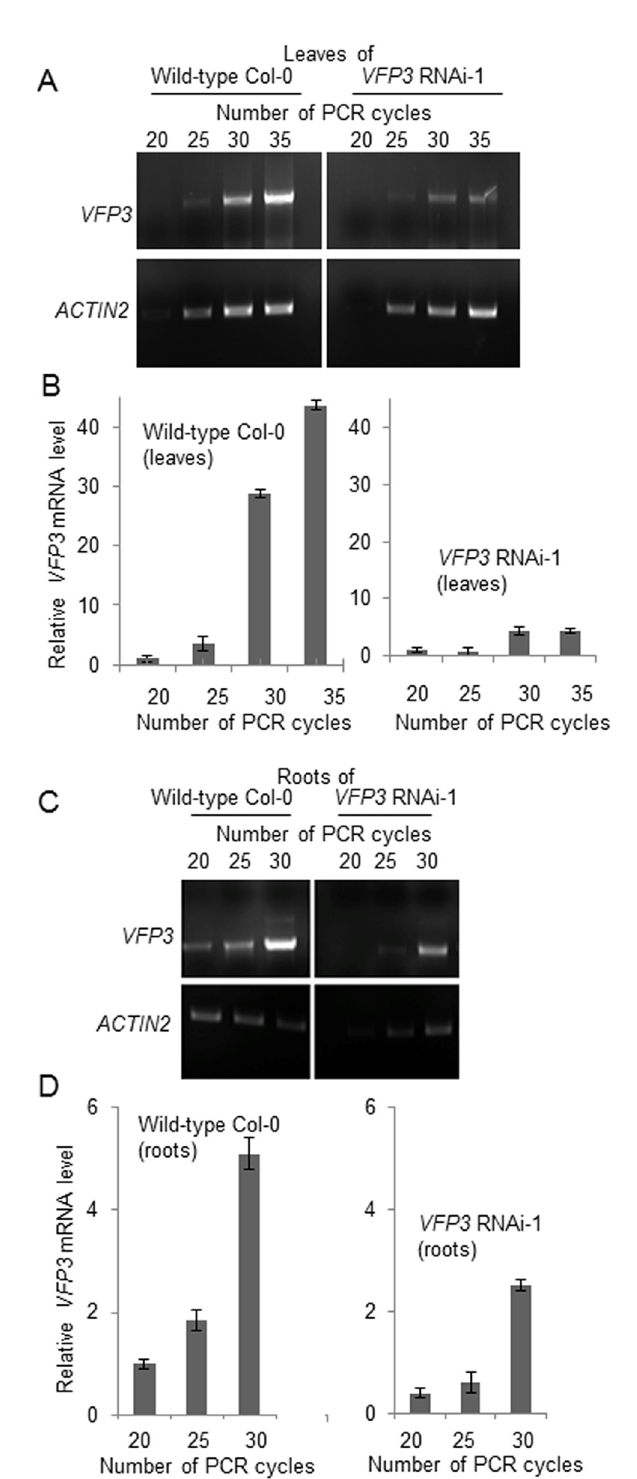
Fig 6. Reduction of VFP3 gene expression in VFP3 RNAi-1 plants. (A) Semi-quantitative RT-PCR analysis of the VFP3 transcript levels in leaves of the wild-type Col-0 and VFP3 RNAi-1 plants. ACTIN2 was used as internal reference. (B) Quantification of VFP3 transcript levels described in (A) normalized to the levels of the ACTIN2 reference. (C) Semi-quantitative RT-PCR analysis of the VFP3 transcript in roots of the wild-type Col-0 and VFP3 RNAi-1 plants. ACTIN2 was used as internal reference. (D) Quantification of VFP3